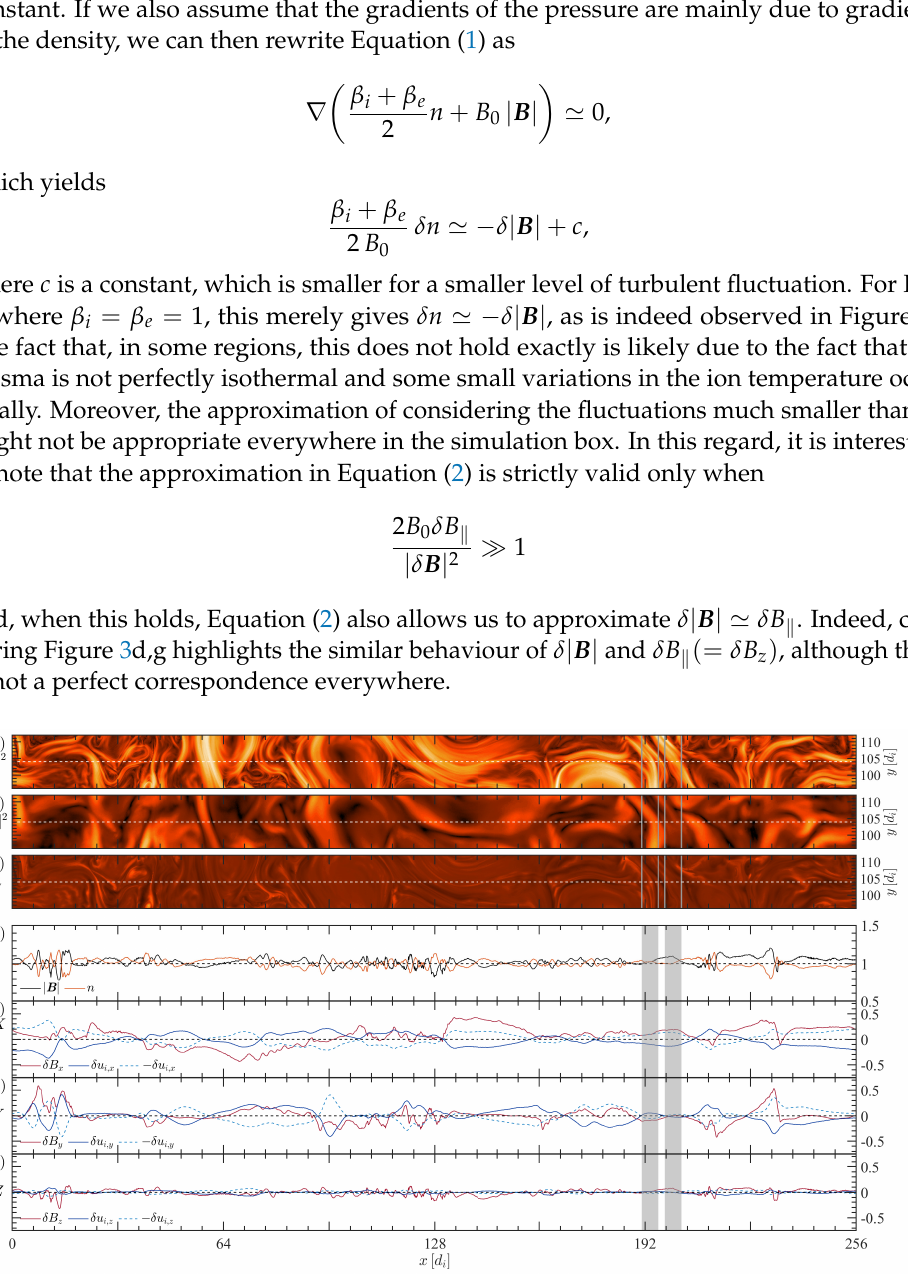
Figure 3. Same as for Run 1 in Figure 2, but for Run